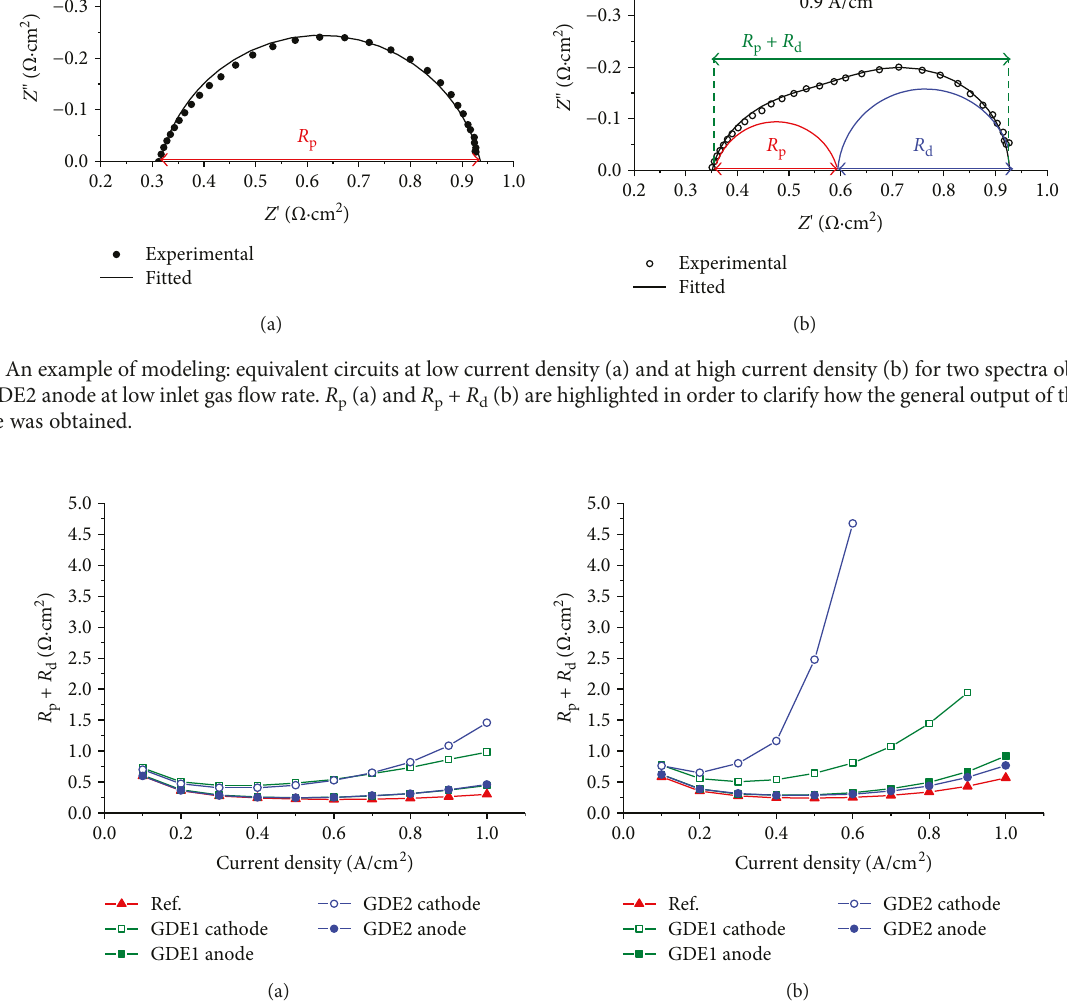
) and the mass transfer resistances ( R p 2